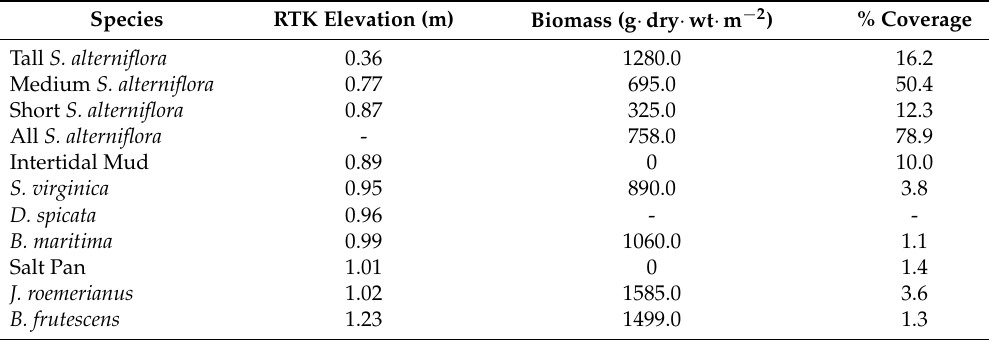
Table 1. Summary of mean elevation (m) for each habitat class (species) measured in the Hladik and Alber [26] Real-Time Kinematic (RTK) survey within the Duplin River watershed, Georgia. Median biomass values and percent coverage of each habitat class are from the Schalles et al. [27] analysis of hyperspectral imagery acquired over the same watershed.